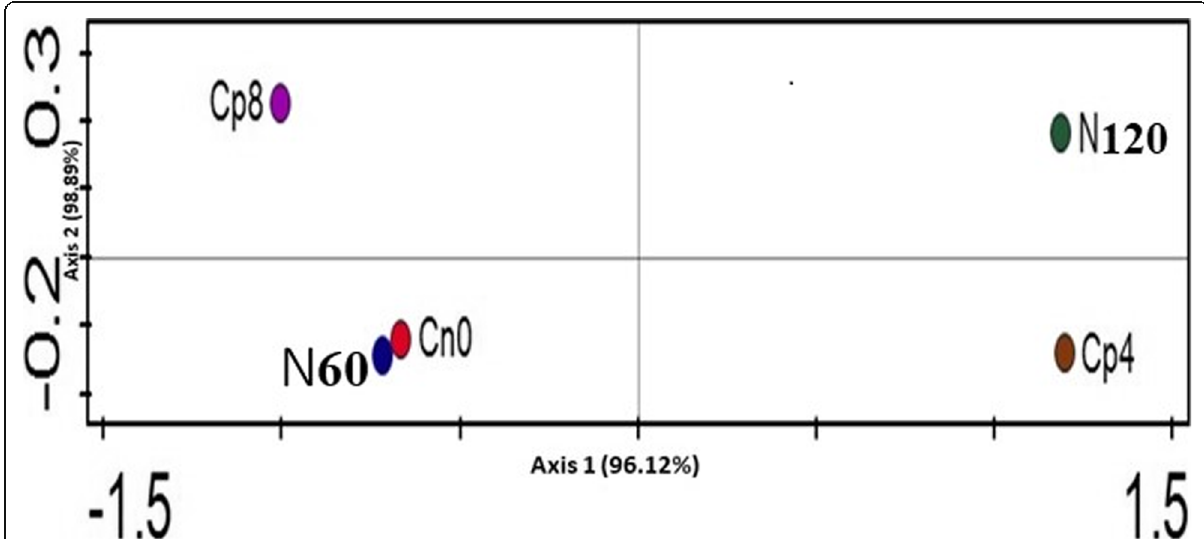
Fig. 1 PCoA (Principal Coordinate Analysis) showing the beta diversity between the maize rhizosphere soils at different fertilization regimes, Cn0